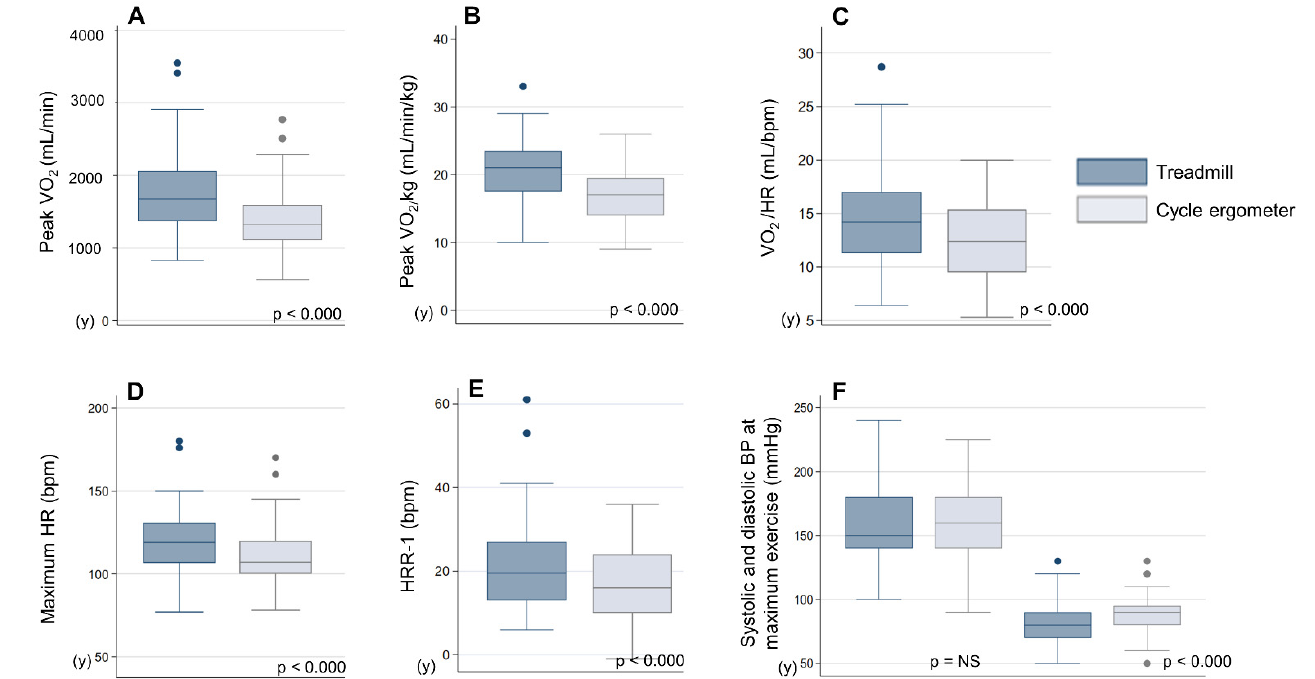
Figure 2. Boxplot of cardiovascular variables and VO 2 on the treadmill and cycle ergometer. ( A ) Peak VO 2 (mL/min), ( B ) peak VO 2/ kg (mL/min/kg), ( C ) VO 2 /HR at VT (mL/bpm), ( D ) maximum HR (bpm), ( E ) HRR-1 (bpm), ( F ) systolic and diastolic BP at the maximum exercise (mmHg). VO 2 : oxygen consumption; HR: heart rate; HRR-1: HR recovery index; BP: blood pressure; NS: not significant.